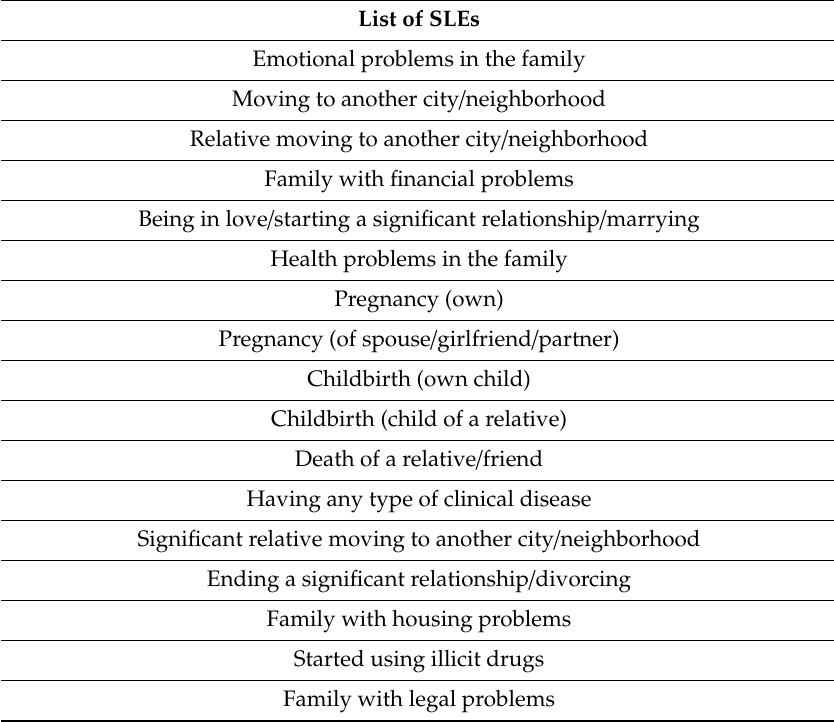
Table A1. List of stressful life events (SLEs) extracted from the Yale OCD Natural History